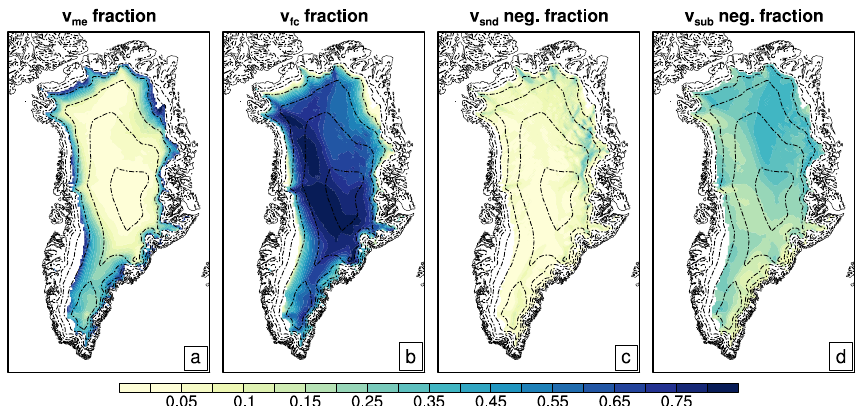
Figure 9. Fraction of surface lowering (negative velocities only) during 1980–2014 caused by (a) melt; (b) firn compaction; (c) snowdrift processes; and (d) sublimation. Up to a fraction of 0.15, the colour scale is divided in steps of 0.025. Above 0.15, the step size is 0.05.